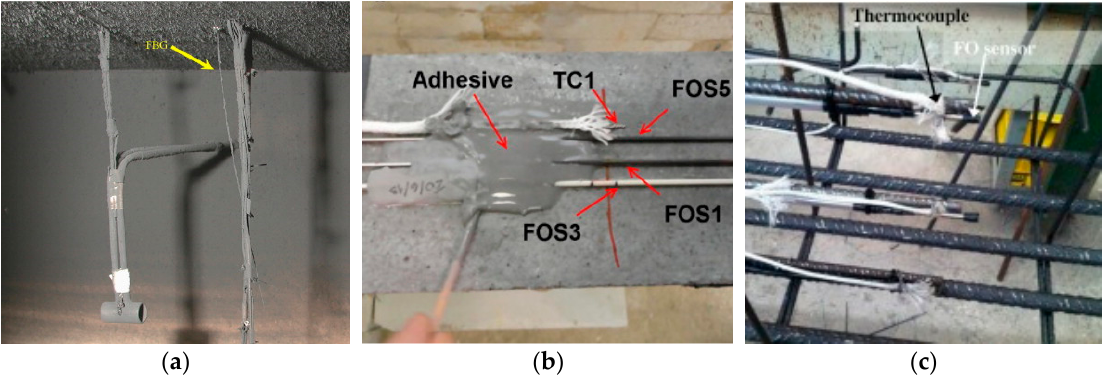
Figure 3. Application of FBG sensors in structural fire testing: ( a ) Gas temperature [11], ( b ) surface- attached on concrete beams [35], and ( c ) embedded in reinforced concrete beams